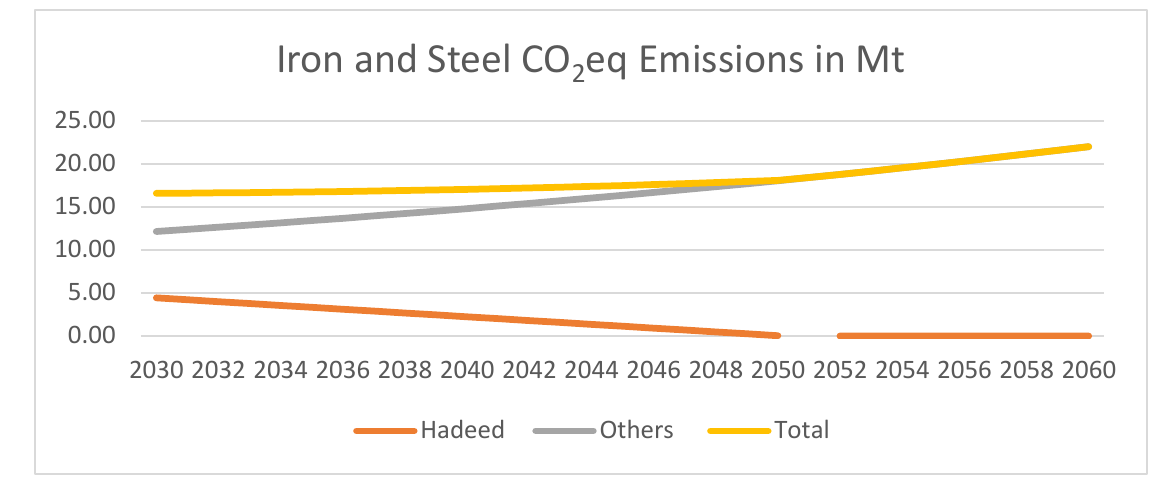
Figure 12. GHG emissions forecast: iron and steel industries.